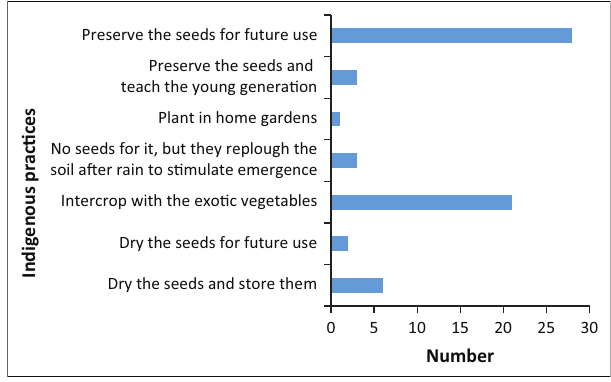
2.75 FIGURE 4: Indigenous practices used to conserve indigenous leafy